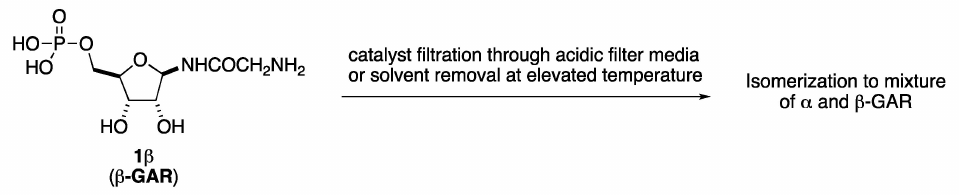
Scheme 8. Isomerization under stressed